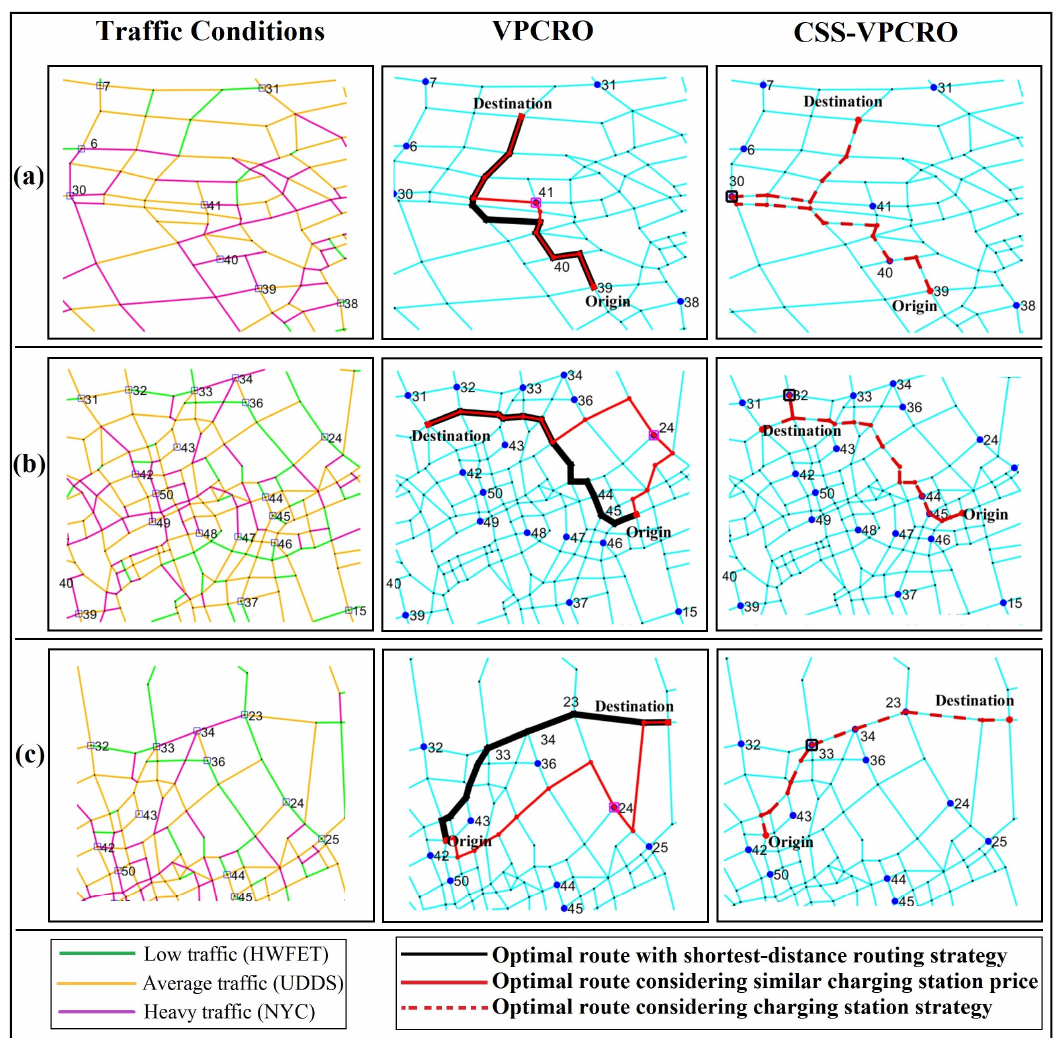
Figure 12. Simulated paths with different routing strategies and electricity price signals: vehicle power train connected routing optimization (VPCRO) and Charging Station Strategy-VPCRO (CSS-VPCRO).